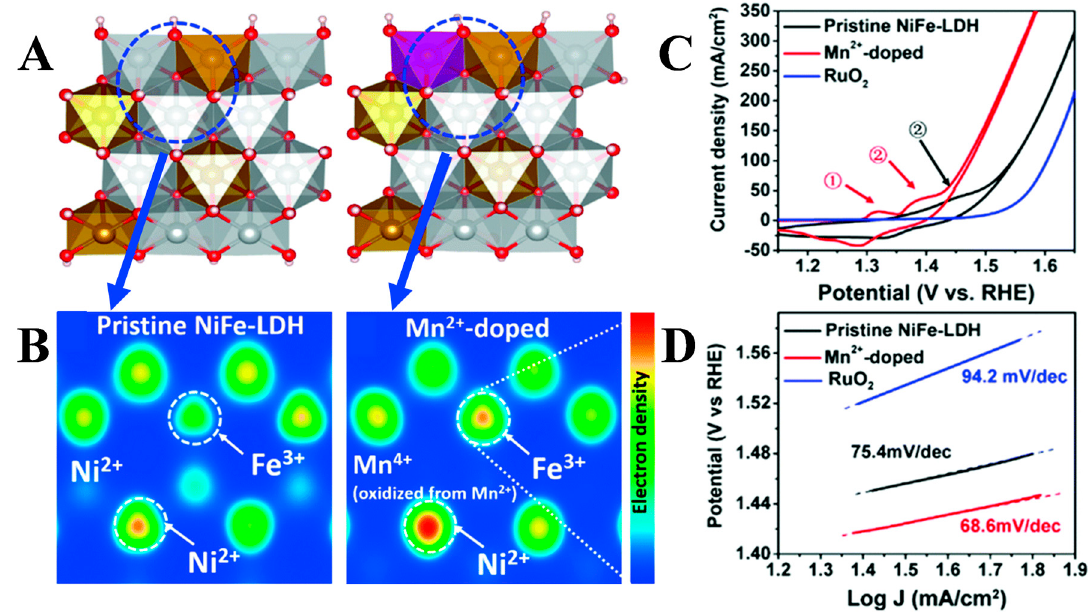
Figure 5. ( A ) Schematic structure of pristine NiFe-LDH and Mn 2+ -doped NiFe-LDH. ( B ) Electronic structure of Ni and Fe sites in pristine NiFe-LDH and Mn 2+ -doped NiFe-LDH in ( A ), respectively. ( C ) CV curves at a scan rate of 1 mV s − 1 ; ( D ) Tafel slopes of pristine NiFe-LDH, Mn 2+ -doped NiFe-LDH and RuO 2 in 1 M KOH solution [128]. Copyright © The Royal Society of Chemistry